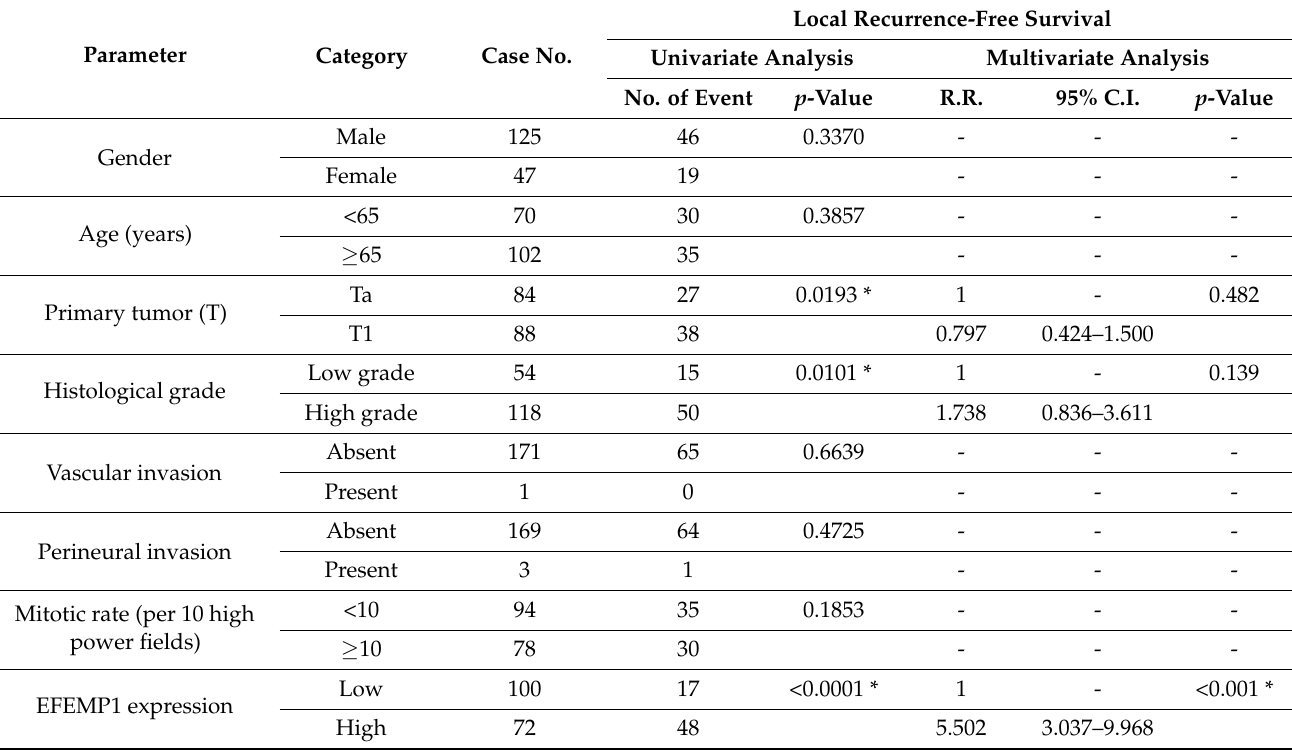
Table 5. Univariate log-rank and multivariate analyses for Bladder Recurrence-free Survivals in NMIBC post TURBT.